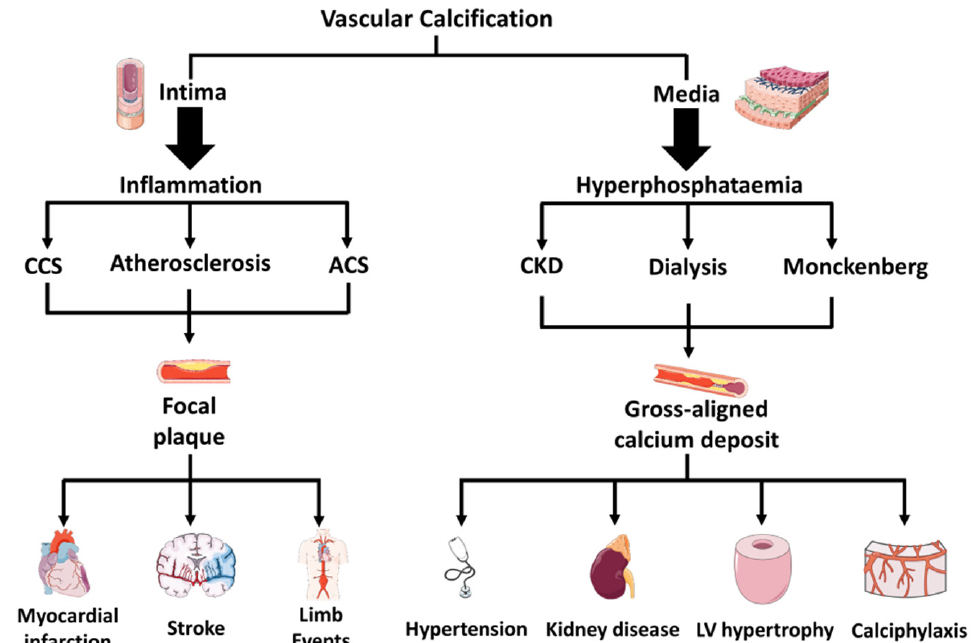
Figure 2. Main differences in calcification occurring in the intimal or media layer of the vessels. CCS = Chronic Coronary Syndrome. ACS = Acute Coronary Syndrome. CKD = Chronic Kidney Disease.